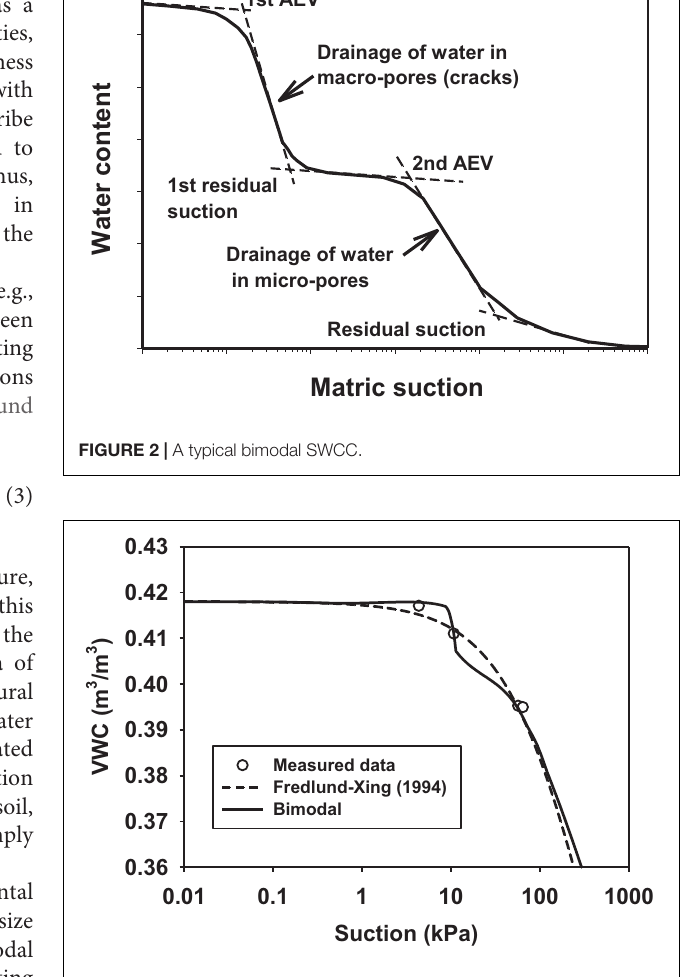
FIGURE 3 | Unimodal and bimodal SWCCs used in the present